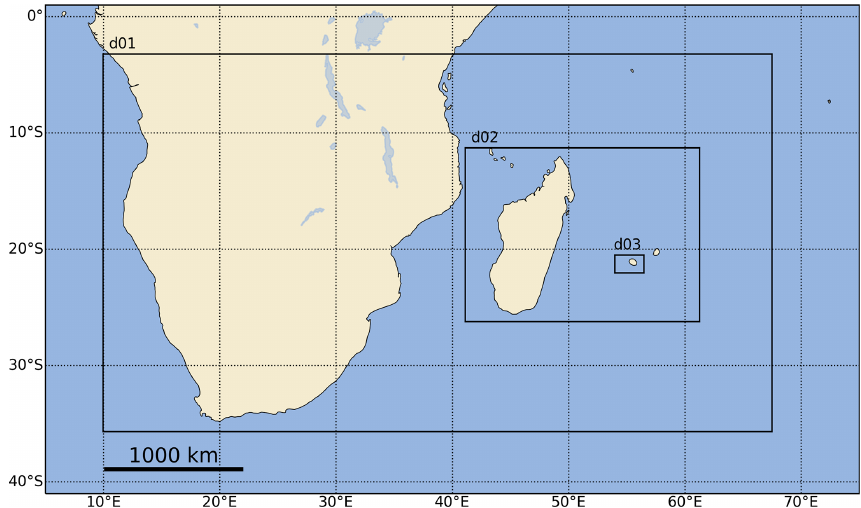
Figure 2. Location of the WRF-GHG domains, with horizontal resolutions of 50km (d01), 10km (d02), and 2km (d03). All domains have 60 (hybrid) vertical levels extending from the surface up to 50hPa.